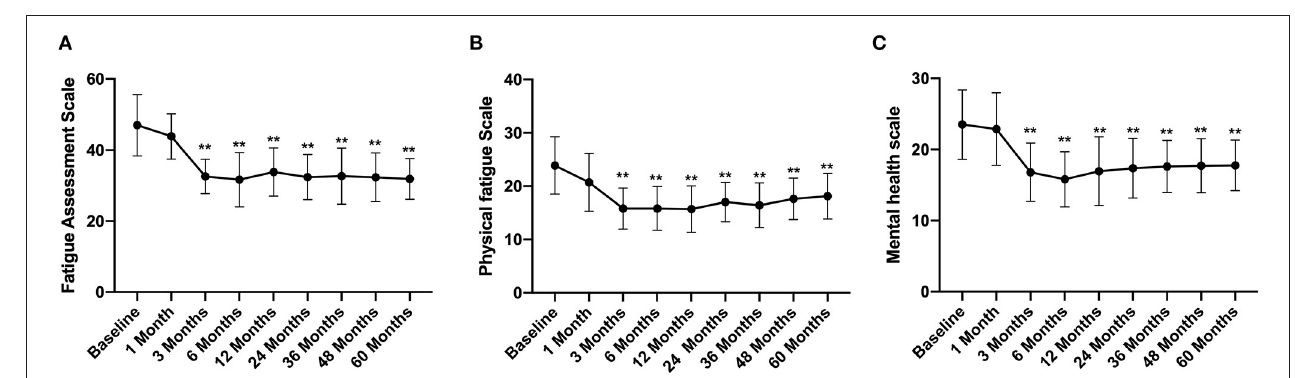
FIGURE 4 | FAS score between groups and their change over time. Difference was compared between each time point of follow-up and before FMT (baseline). (A) total score; (B) physical fatigue; (C) mental health. FAS, Fatigue Assessment Scale. Data are presented as x ± s , statistical analyses: univariate analysis of variance, ** p <